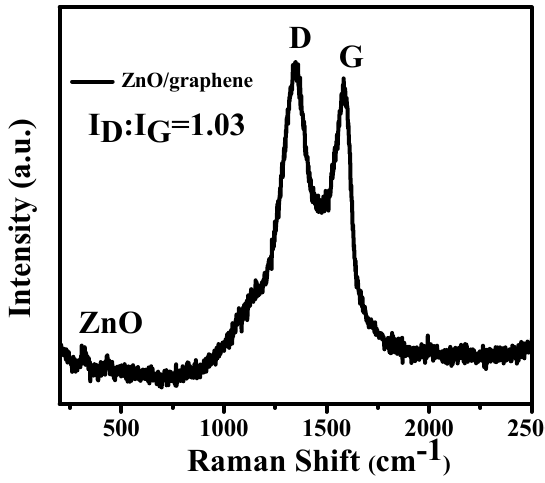
Figure 5. Raman spectrum of ZnO/graphene composite.